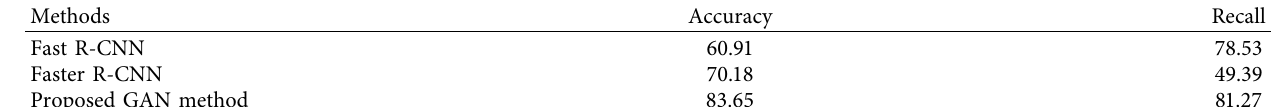
Table 4: Comparison of test results of different methods.